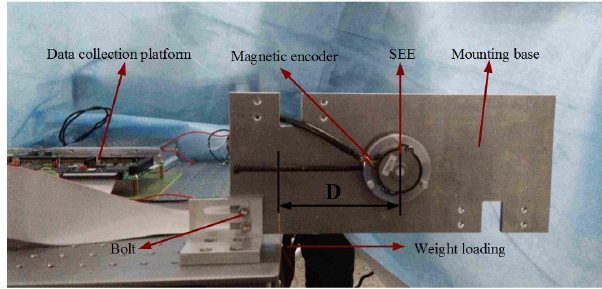
Figure 5. Configuration of the double compact elastic module. 1: the shank segment, 2: the interaction cuff, 3: encoder measuring the position of elastic element, 4: the elastic element of PEM, 5: the thigh, 6: bevel gear pair, 7: the connection part, 8: the encoder, 9: the elastic element of DEM.